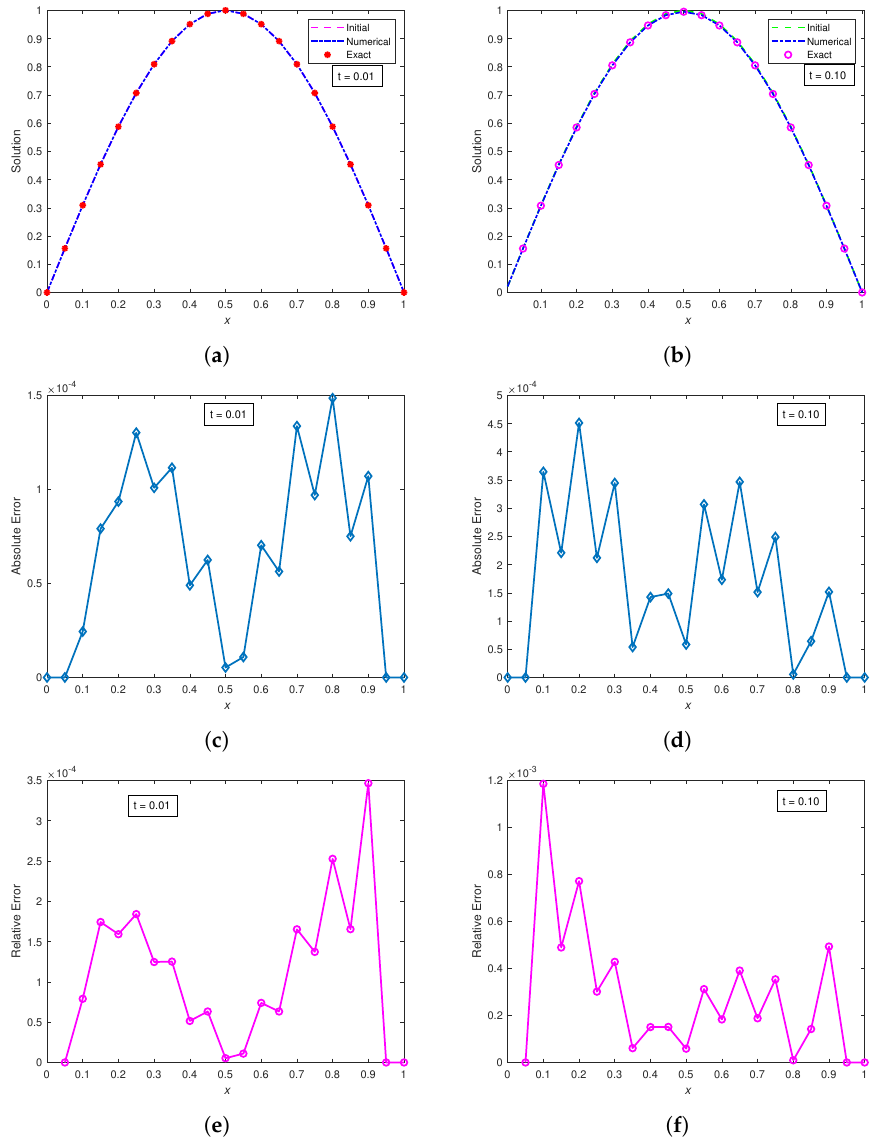
Figure 9. Plots of the exact and numerical solution vs. x ∈ [ 0,1 ] at times t = 0.01, 0.10, using a classical finite difference scheme with ∆ t = 10 − 5 , ∆ x = 0.05 with corresponding absolute and relative errors vs. x (at times t = 0.01, 0.10), respectively. ( a ) ∆ t = 1.0 × 10 − 5 , (Time = 0.01); ( b ) ∆ t = 1.0 × 10 − 5 , (Time = 0.10); ( c ) ∆ t = 1.0 × 10 − 5 , (Time = 0.01); ( d ) ∆ t = 1.0 × 10 − 5 , (Time = 0.10); ( e ) ∆ t = 1.0 × 10 − 5 , (Time = 0.01); ( f ) ∆ t = 1.0 × 10 − 5 , (Time =